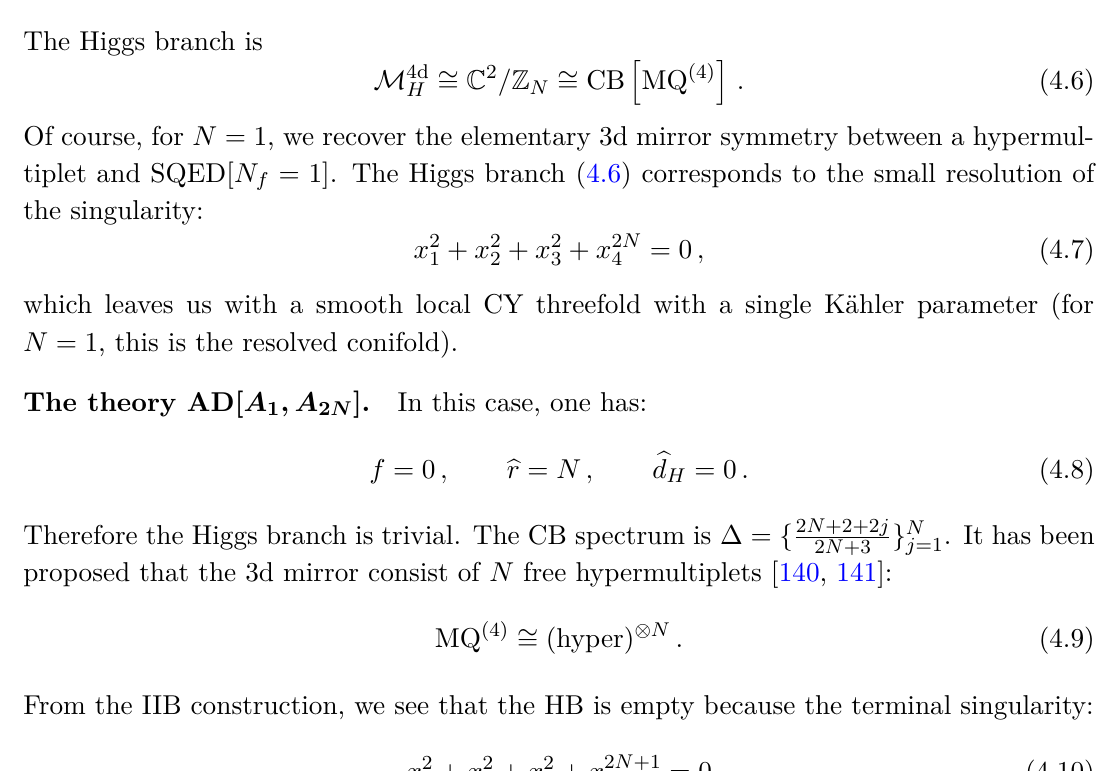
. Note also that [ A X